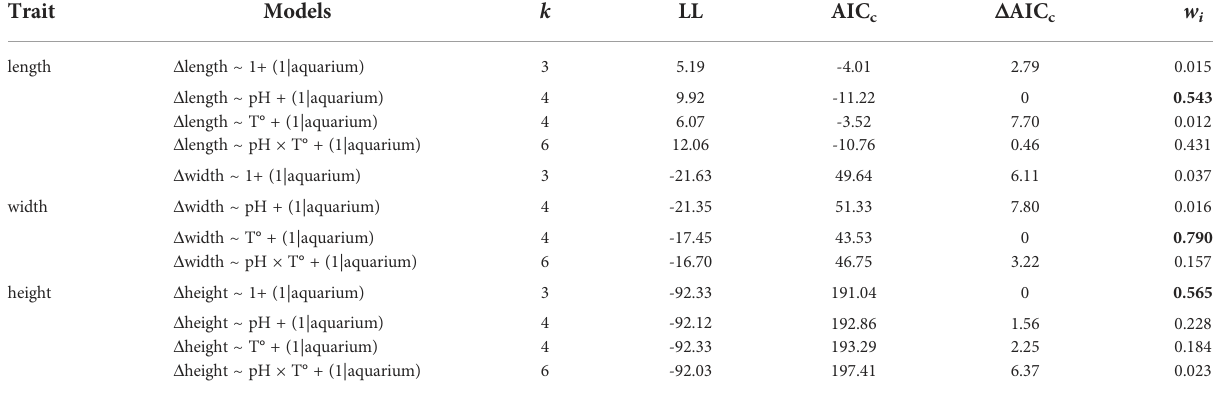
TABLE 3 Hierarchical general linear mixed models for morphological changes of Ameghinomya antiqua juvenile clams.